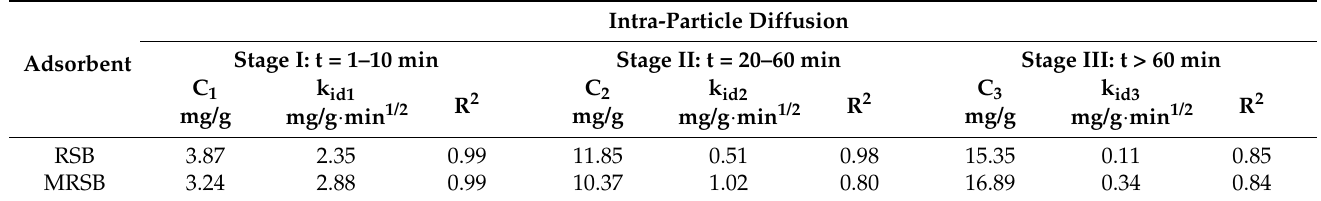
Table 5. Intra-particle diffusion kinetic parameters of SO adsorption on RSB and MRSB.